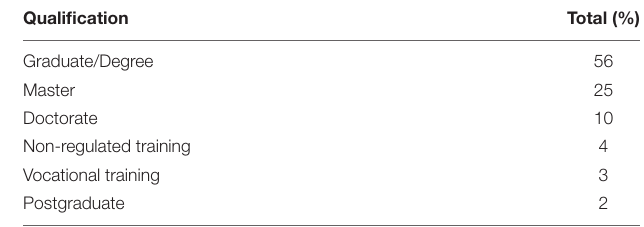
TABLE 2 | Higher qualifications obtained by members of the consulting companies.